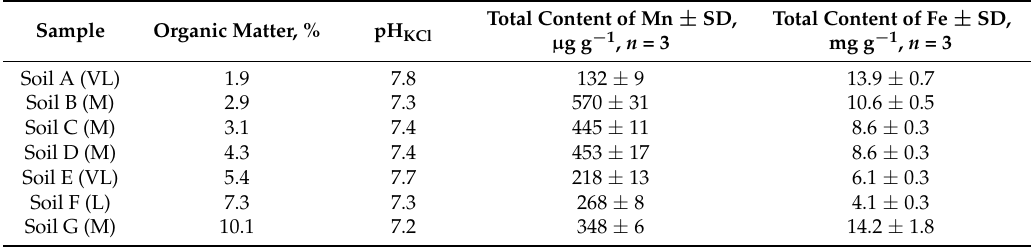
The characteristics of soil samples collected from the contaminated area of an old leather